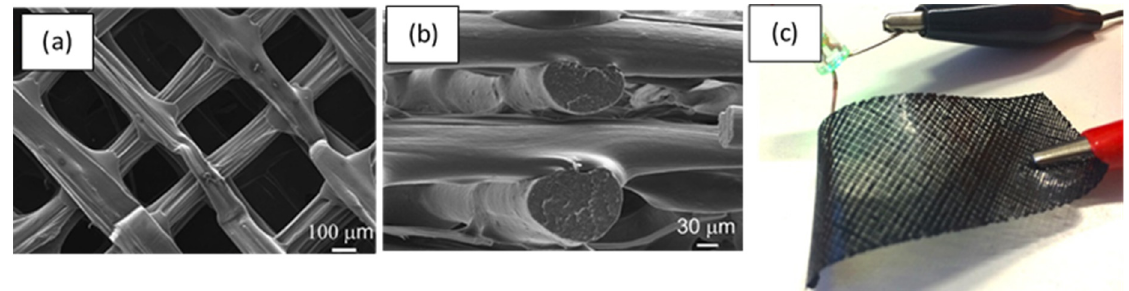
Figure 35. Carbon nanotube prototype with woven structure printed via liquid deposition modelling (a variant of FDM). The microstructure is displayed from ( a ) a top view and ( b ) a side view, with scale bars of 100 μ m and 30 μ m, respectively, and ( c ) shows the experimental confirmation of the prototypes electrical properties by connecting it to a simple electric circuit that lights up an LED [159]. (Reprinted from Composites Part A: Applied Science and Manufacturing, Volume 76, G. Postiglione, et al., ‘Conductive 3D microstructures by direct 3D printing of polymer/carbon nanotube nanocomposites via liquid deposition modeling’, Pages 110-114, Copyright (2015), with permission from Elsevier).